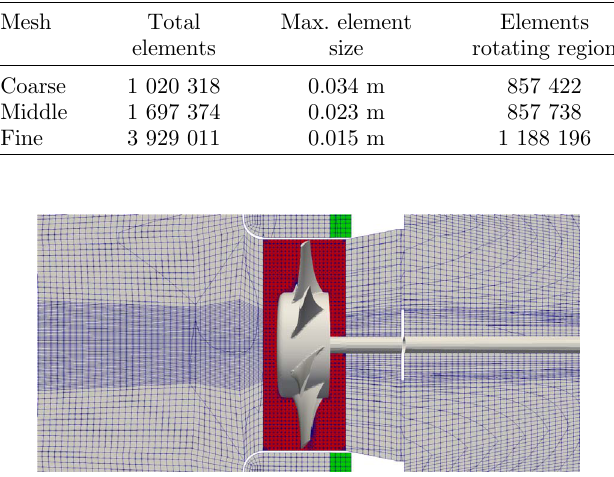
Table 4. Different meshes used for the acoustic propagation simulation.